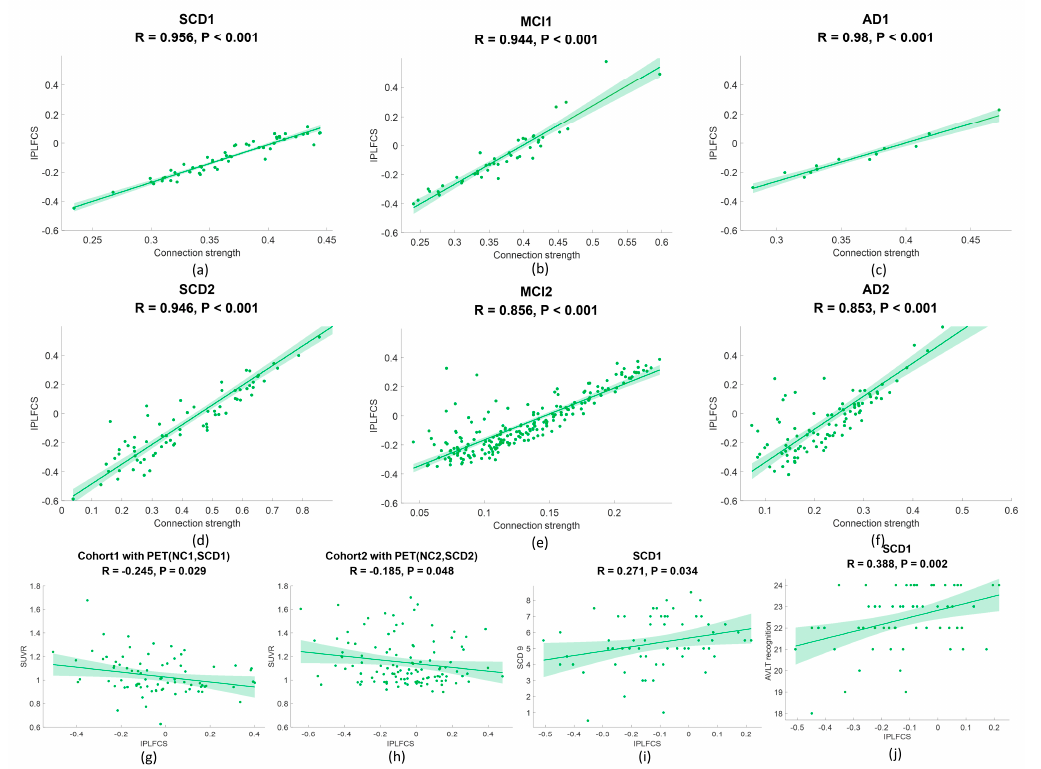
Figure 4. Linearities between IPLFCS and SUVR and clinical scores in different groups. ( a ) Correlation analysis between IPLFCS and FC in the SCD1. ( b ) Correlation analysis between IPLFCS and FC in the MCI1. ( c ) Correlation analysis between IPLFCS and FC in the AD1. ( d ) Correlation analysis between IPLFCS and FC in the SCD2. ( e ) Correlation analysis between IPLFCS and FC in the MCI2. ( f ) Correlation analysis between IPLFCS and FC in the AD2. ( g ) Correlation analysis between IPLFCS and SUVR of LMTG in Cohort 1 with PET. ( h ) Correlation analysis between IPLFCS and SUVR of LMTG in Cohort 2 with PET. ( i ) Correlation analysis between IPLFCS of LMTG and SCD-9 scores in the SCD1 group. ( j ) Correlation analysis between IPLFCS of LMTG and AVLT recognition scores in the SCD1 group.